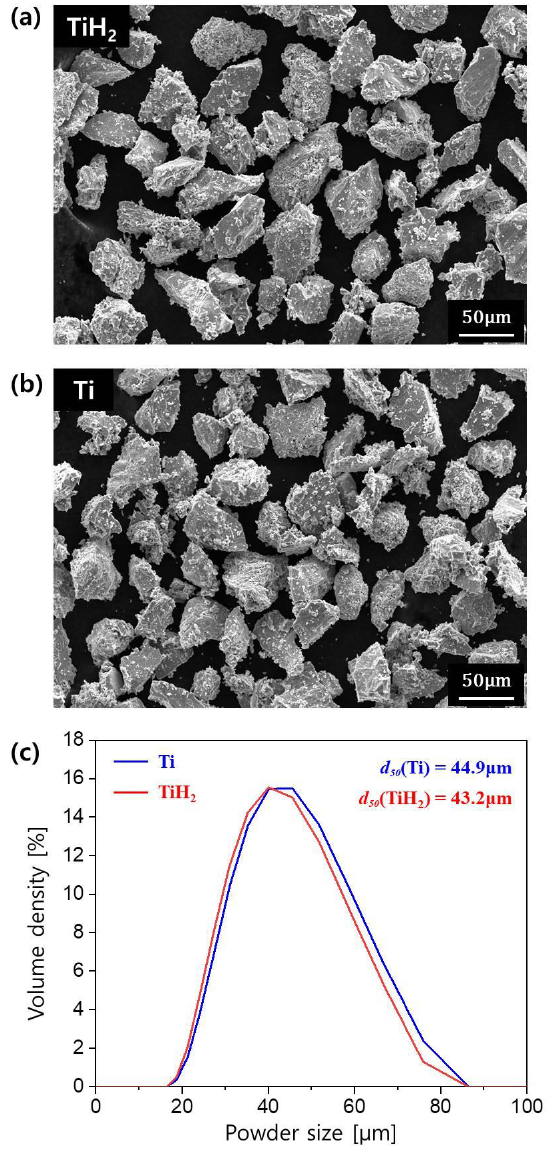
Figure 1. Morphology of ( a ) TiH 2 and ( b ) Ti powders fabricated by hydrogenation–dehydrogenation (HDH) process and ( c ) size distribution of TiH 2 and Ti powders.